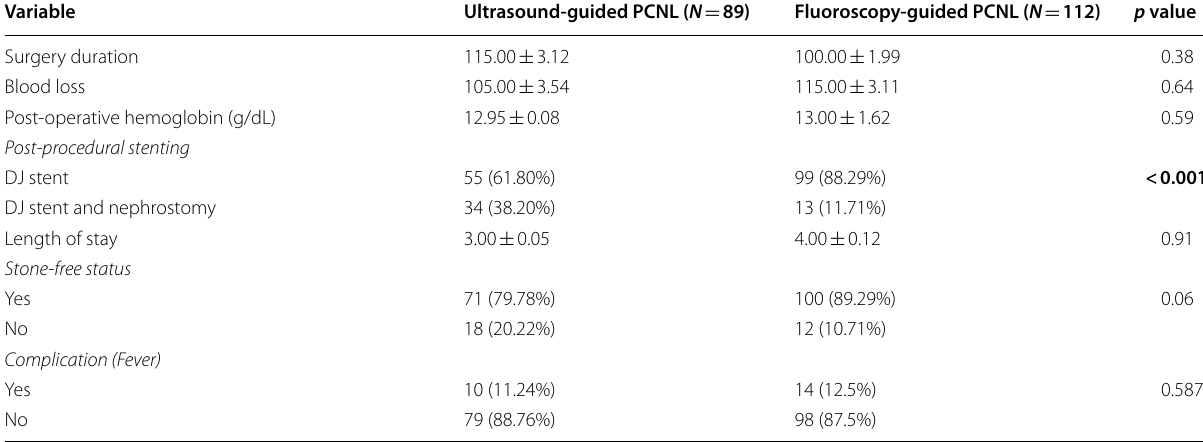
Table 3 Operative and Post-Operative Outcome